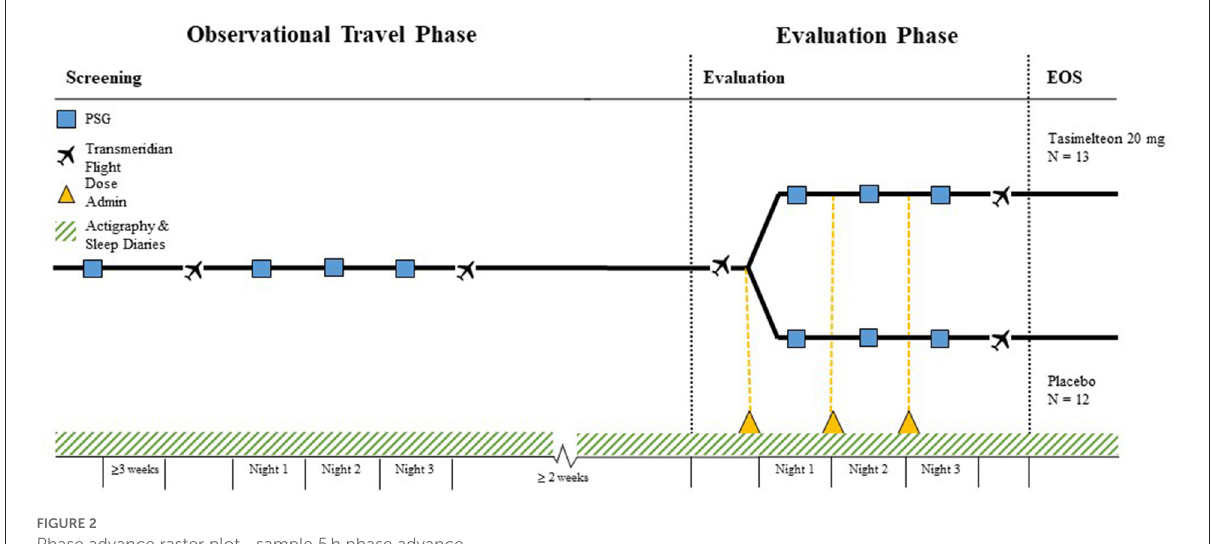
FIGURE2 Phase advance raster plot—sample 5h phase